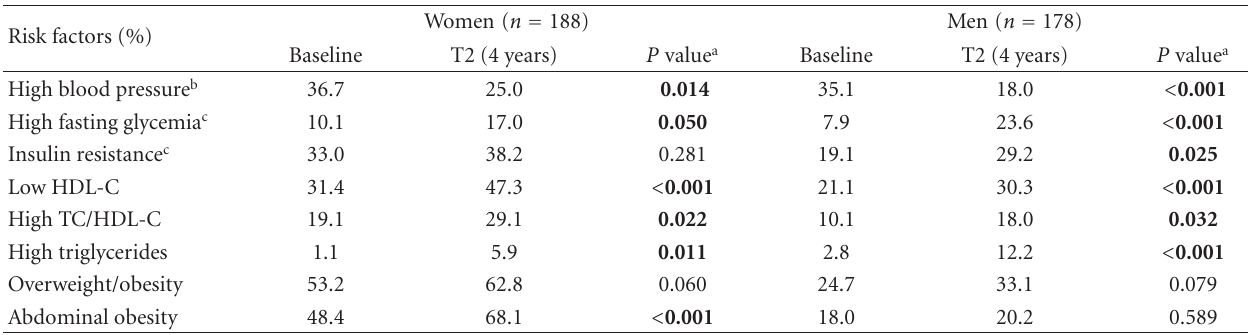
a P values for χ 2 test.